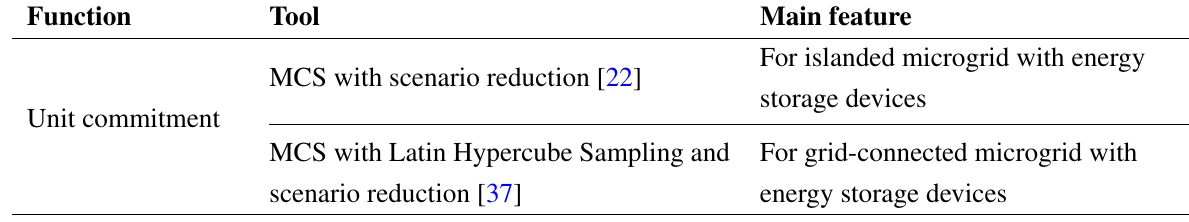
Table 4. Stochastic optimization tools for microgrid operation. V2G, vehicle-to-grid.